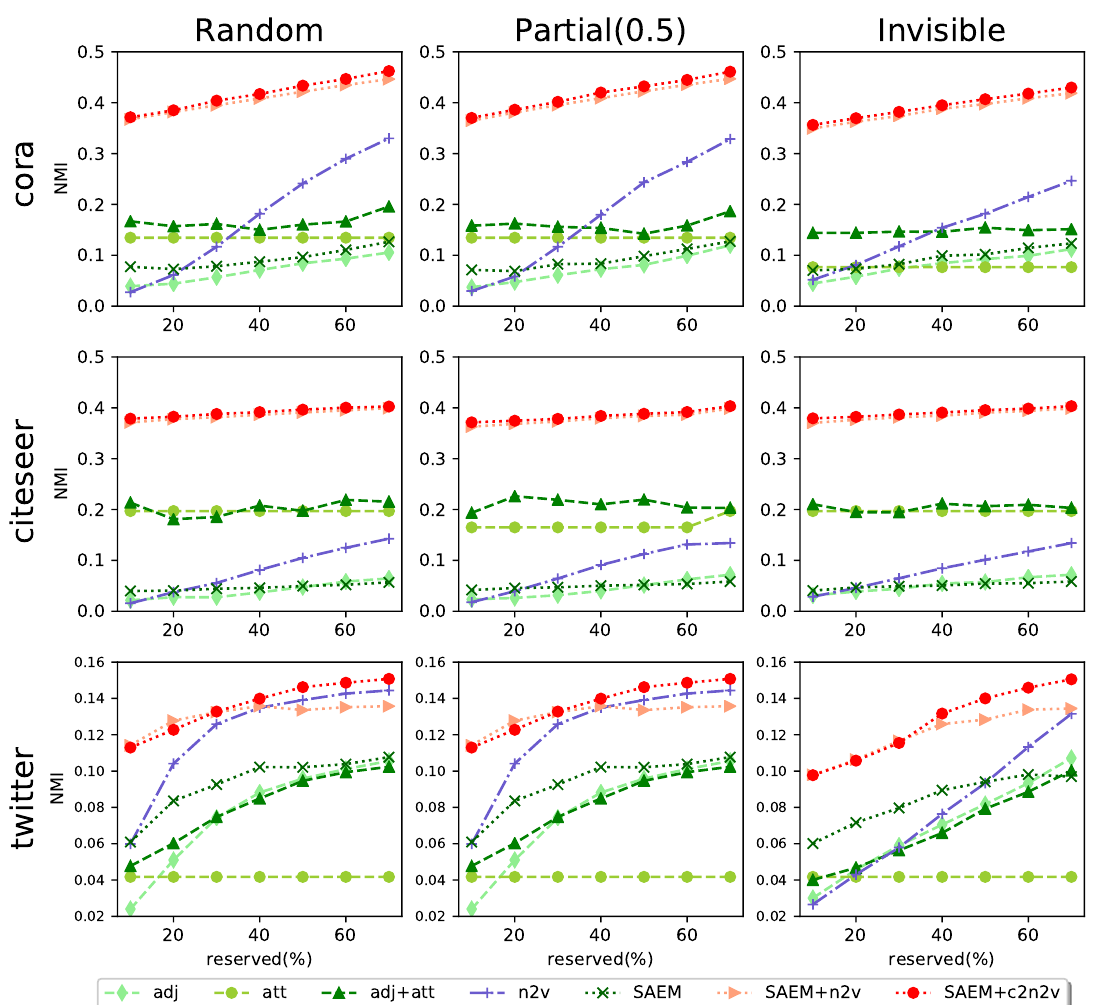
Figure 2. Results of Normalized Mutual Information (NMI) scores on community detection across three privacy settings and three